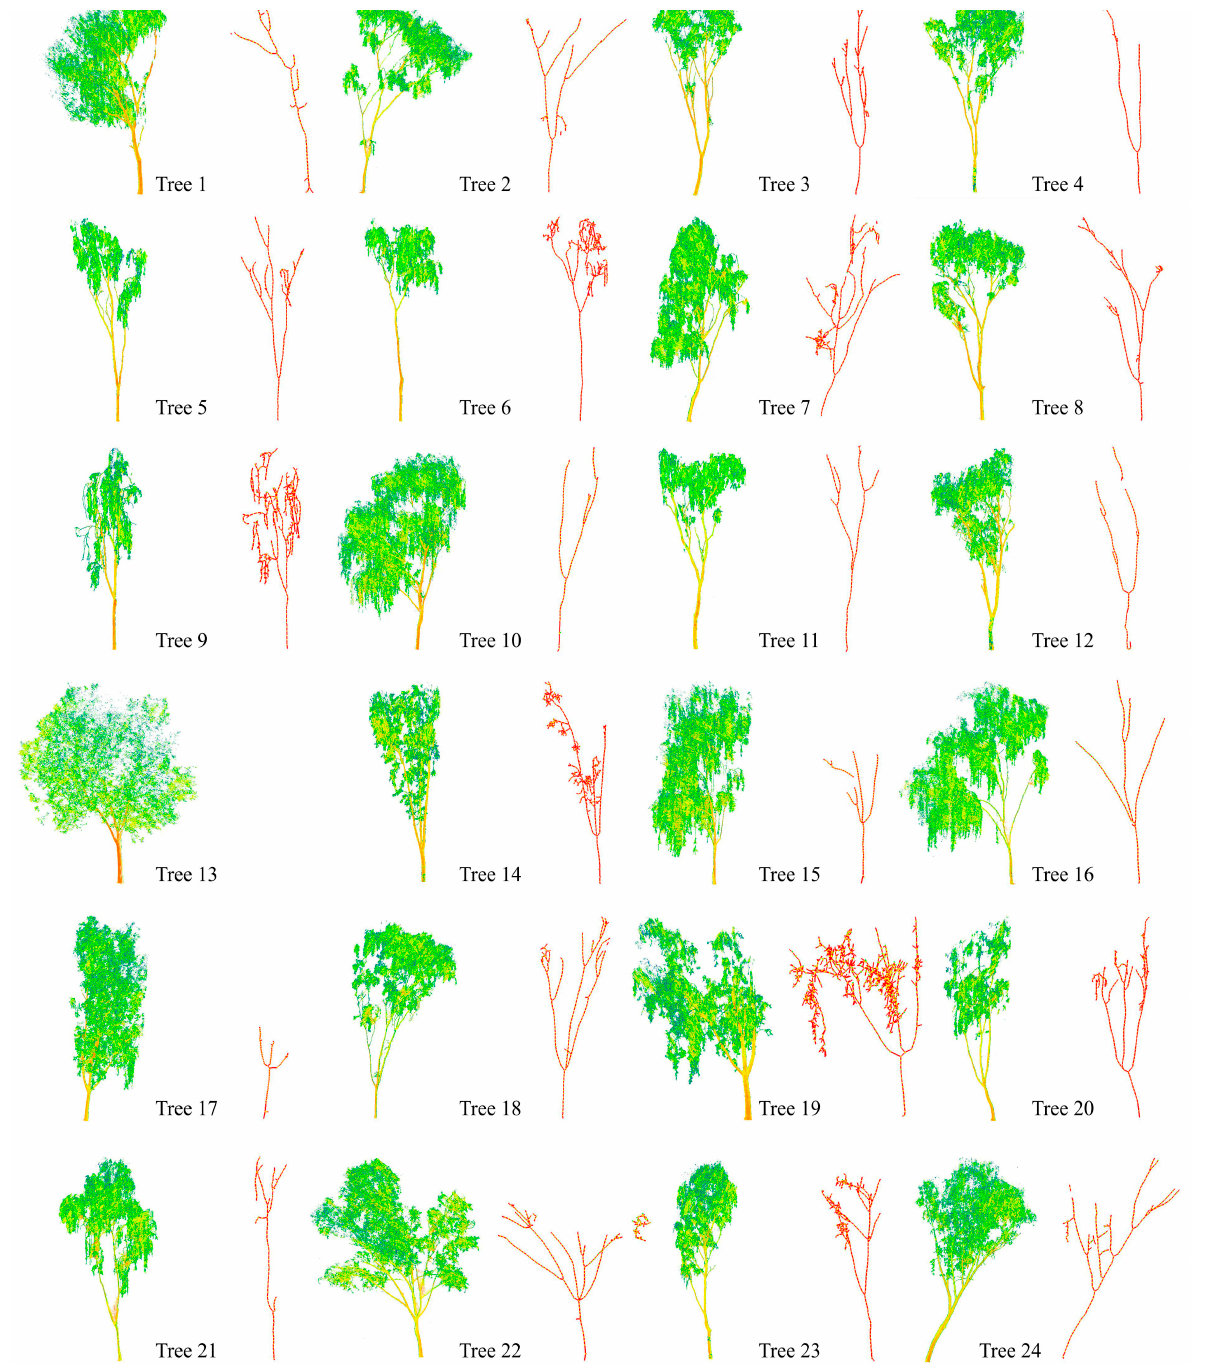
Figure 7. The obtained tree skeletons of 24 trees based on the GSA algorithm. The skeleton result of each tree contains two subgraphs (left: raw tree point cloud; right: final tree skeleton).